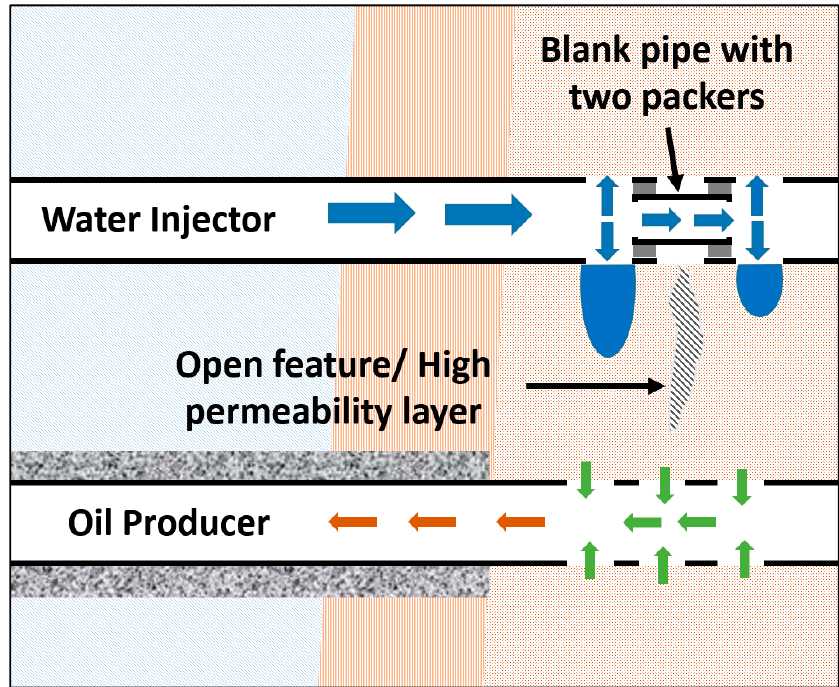
Figure 8. Two packers above and below a blank pipe to avoid injecting the water in open features or high permeability layers.